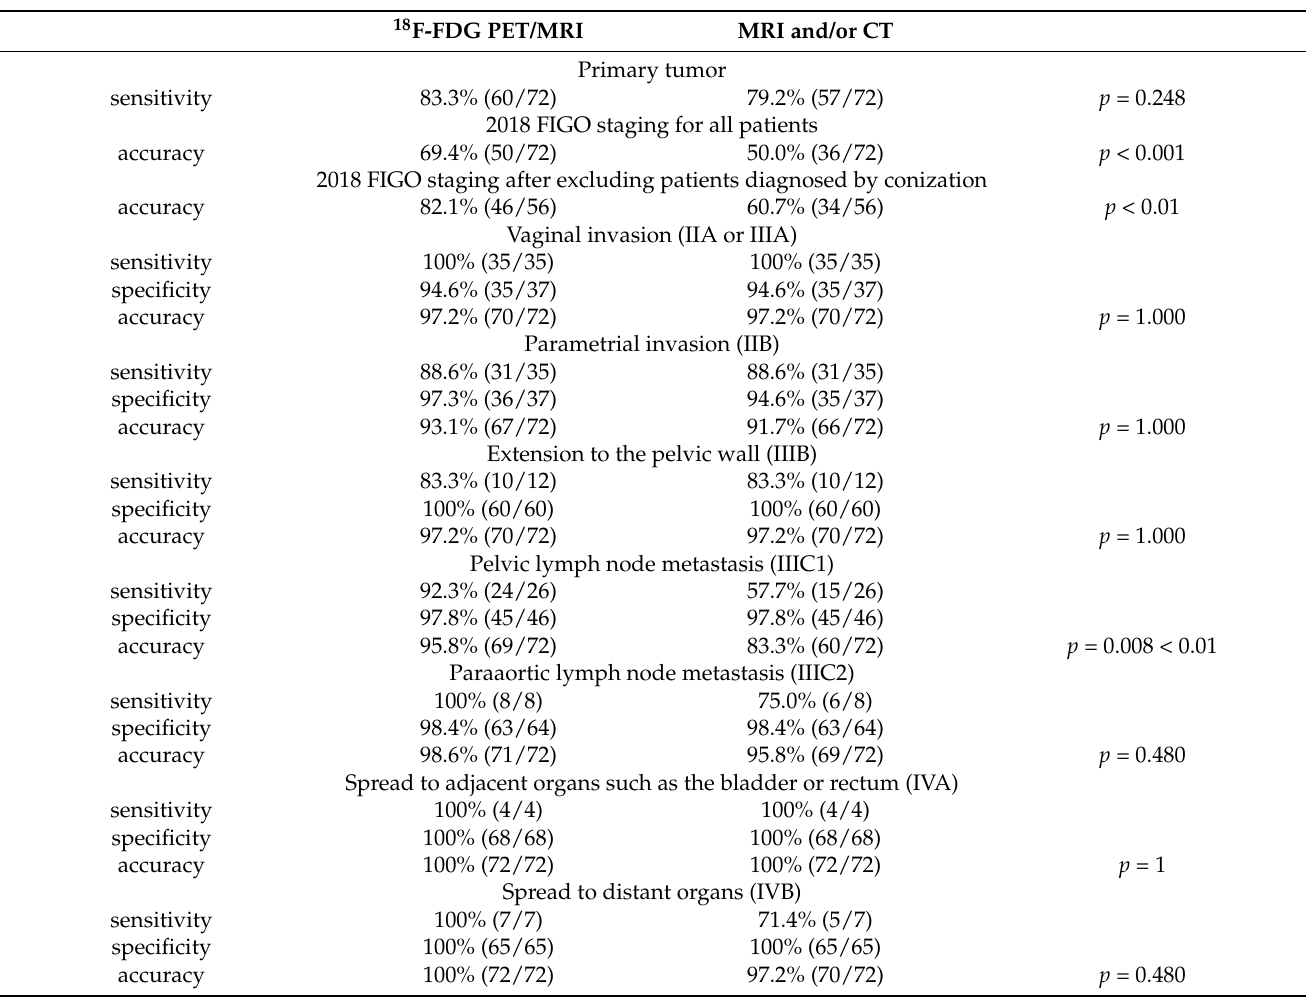
Table 2. Comparison of 18 F-FDG PET/MRI with MRI and/or CT for patient-based 2018 FIGO staging and detection of recurrence.